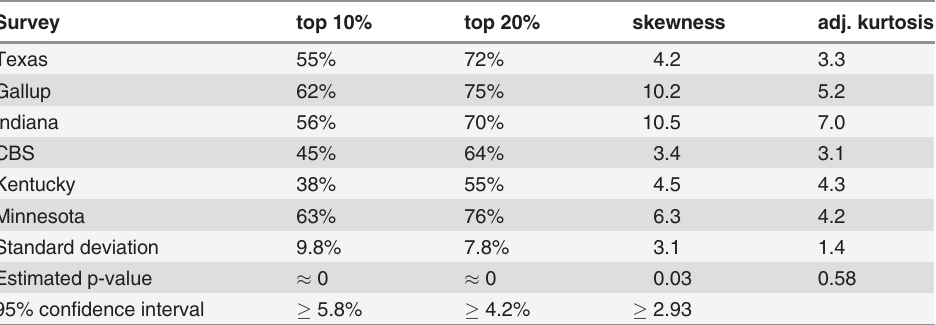
Table 3. Columns 2 and 3 report the % of total lottery spending due to the top 10% and 20% of spenders respectively. Column 4 reports the skewness and column 5 reports the skewness-adjusted kurtosis de fi ned in [43] for the spending reported in each survey. The bottom three rows give the results of a 6-sample permutation test with test statistic the standard deviation of the numbers in the higher rows. Survey top 10% top 20%